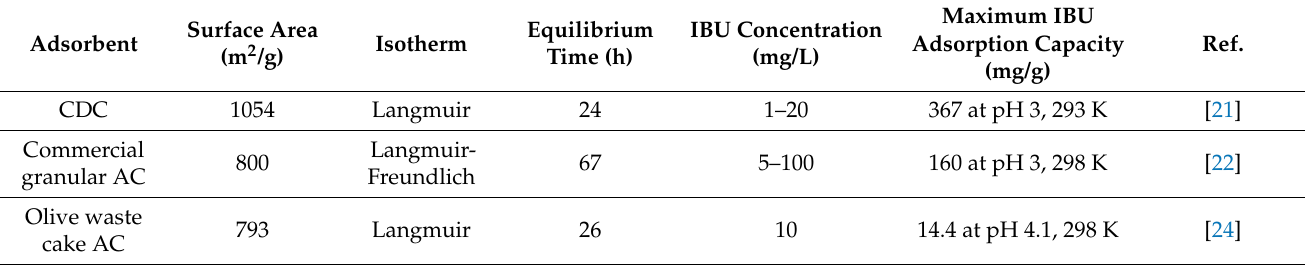
Table 4. IBU adsorption capacities on various